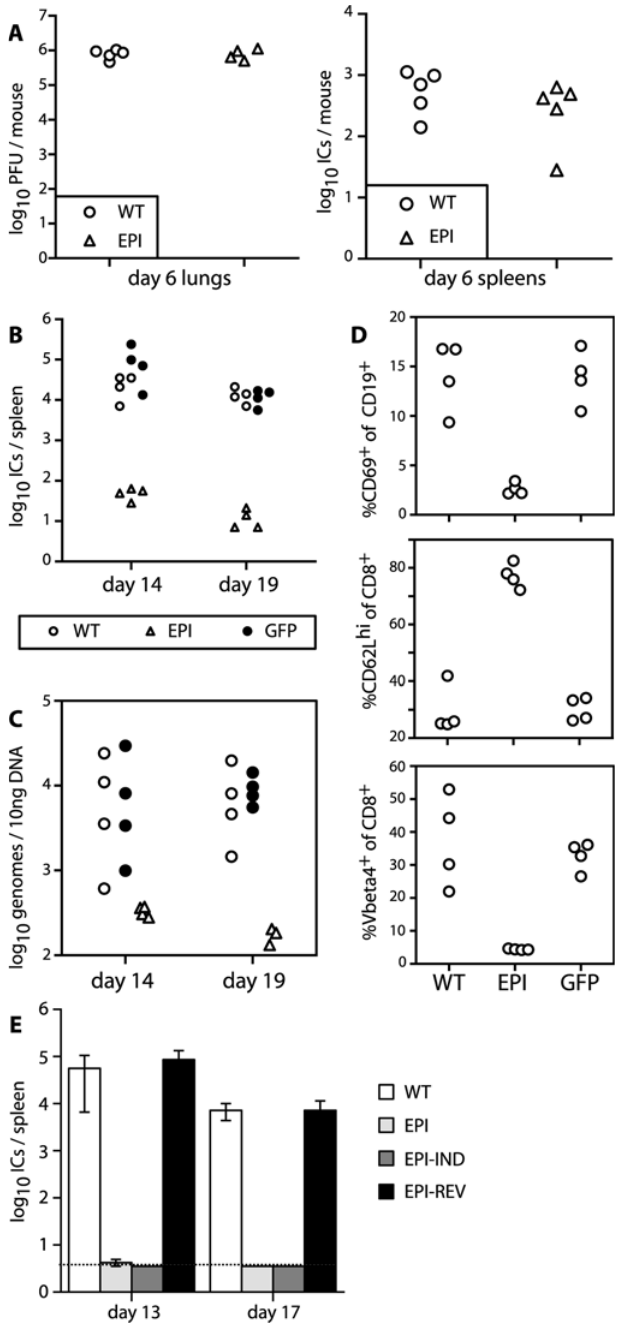
Figure 4. Replication of the IRES-EPI Virus In Vivo (A) Six days after intranasal infection with WT or EPI viruses as indicated, infectious virus in lungs was titred by plaque assay (left panel) and infectious plus latent virus in spleens was titred by infectious centre assay (right panel). Each point shows an individual mouse. Pre-formed, infectious virus was undetectable in equivalent, freeze-thawed spleen samples, so the infectious centres represent latent virus. (B) By 14 d post-infection, infectious centre titres were much lower with the EPI virus than with WT. The GFP control virus is shown for comparison. This difference was preserved at day 19 post-infection, indicating that the EPI virus was not merely delayed in host colonisation. (C) DNA was extracted from spleens and its viral genome content quantitated by real-time PCR. Genome loads broadly reflected the infectious centre titres, indicating that the viral load was reduced rather than the efficiency of ex vivo reactivation.